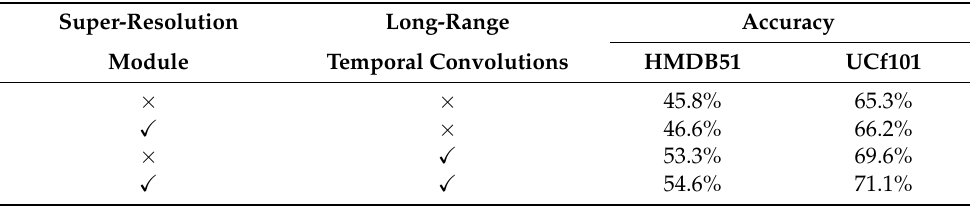
Table 2. Performance of our proposed method with/without two mechanisms on HMDB51 and